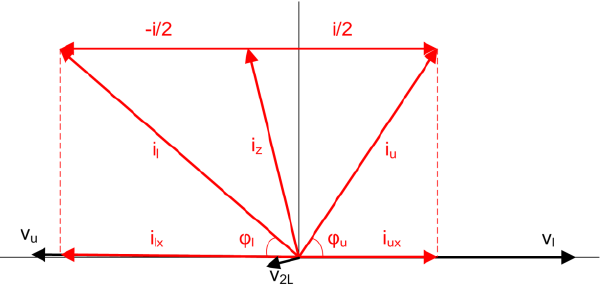
Figure 5. Vector diagram of the variables involved in power transmission from the arms. All of them are 50 Hz variables (harmonic 1).